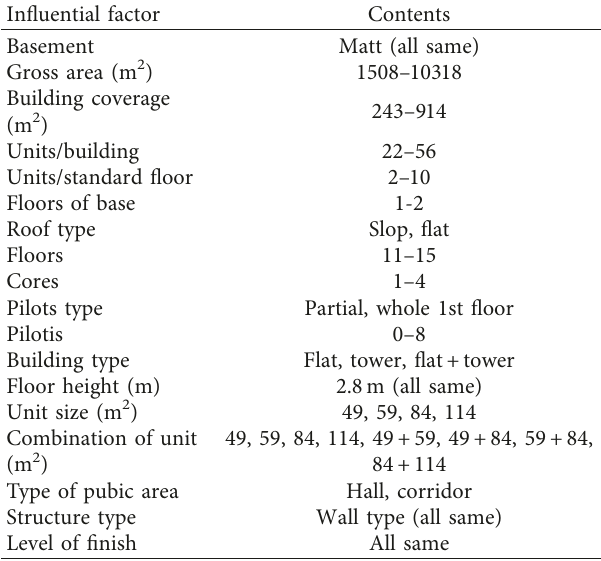
Table 2: Influential factors of Korean residential